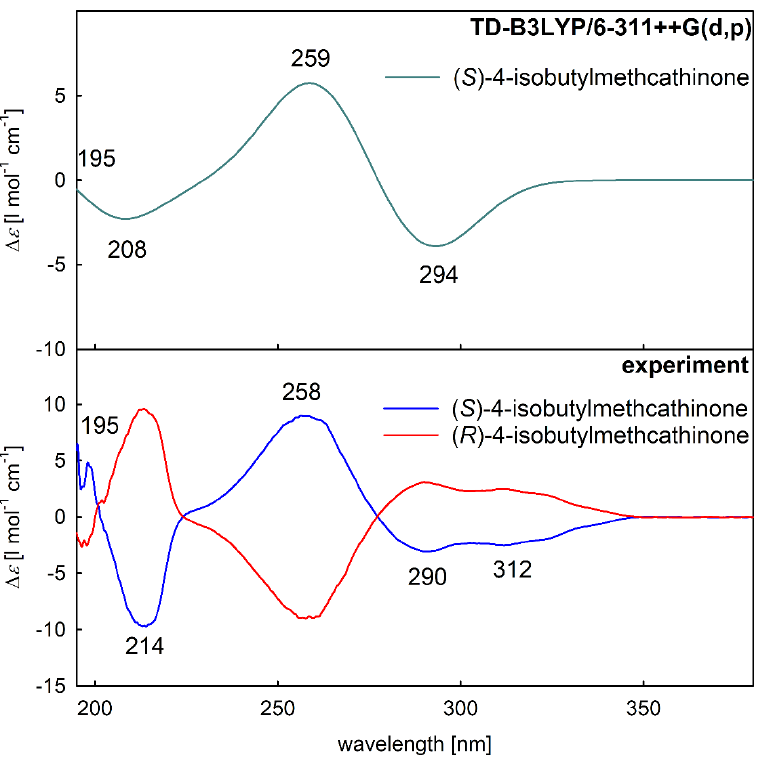
Figure 6. Comparison of the ECD spectra of 4-isobutylcathinone in MeOH: the simulated spectrum of ( S )-enantiomer at the TD-B3LYP/6-311++G(d,p) level ( top ) and experimental spectra ( bottom ).